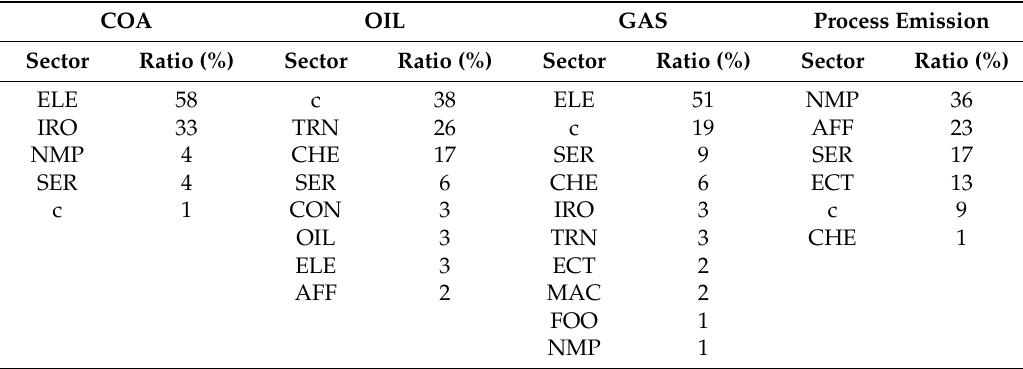
Table 4. Greenhouse gas (GHG) emission ratio by source and sector.